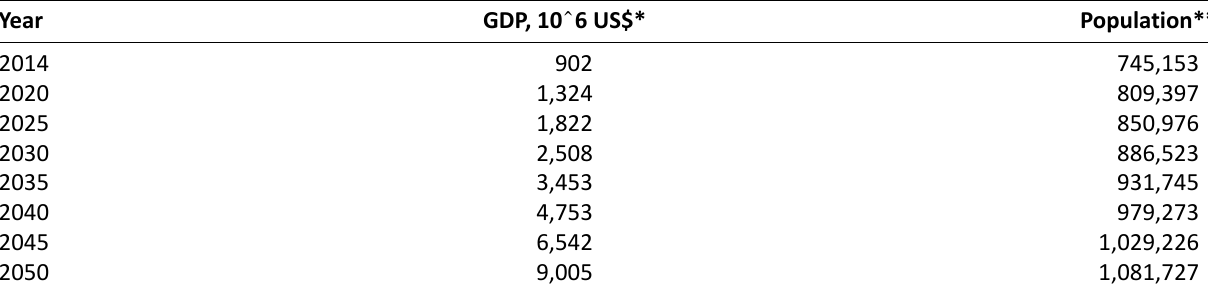
Table A2. GDP and population projection under the BAU